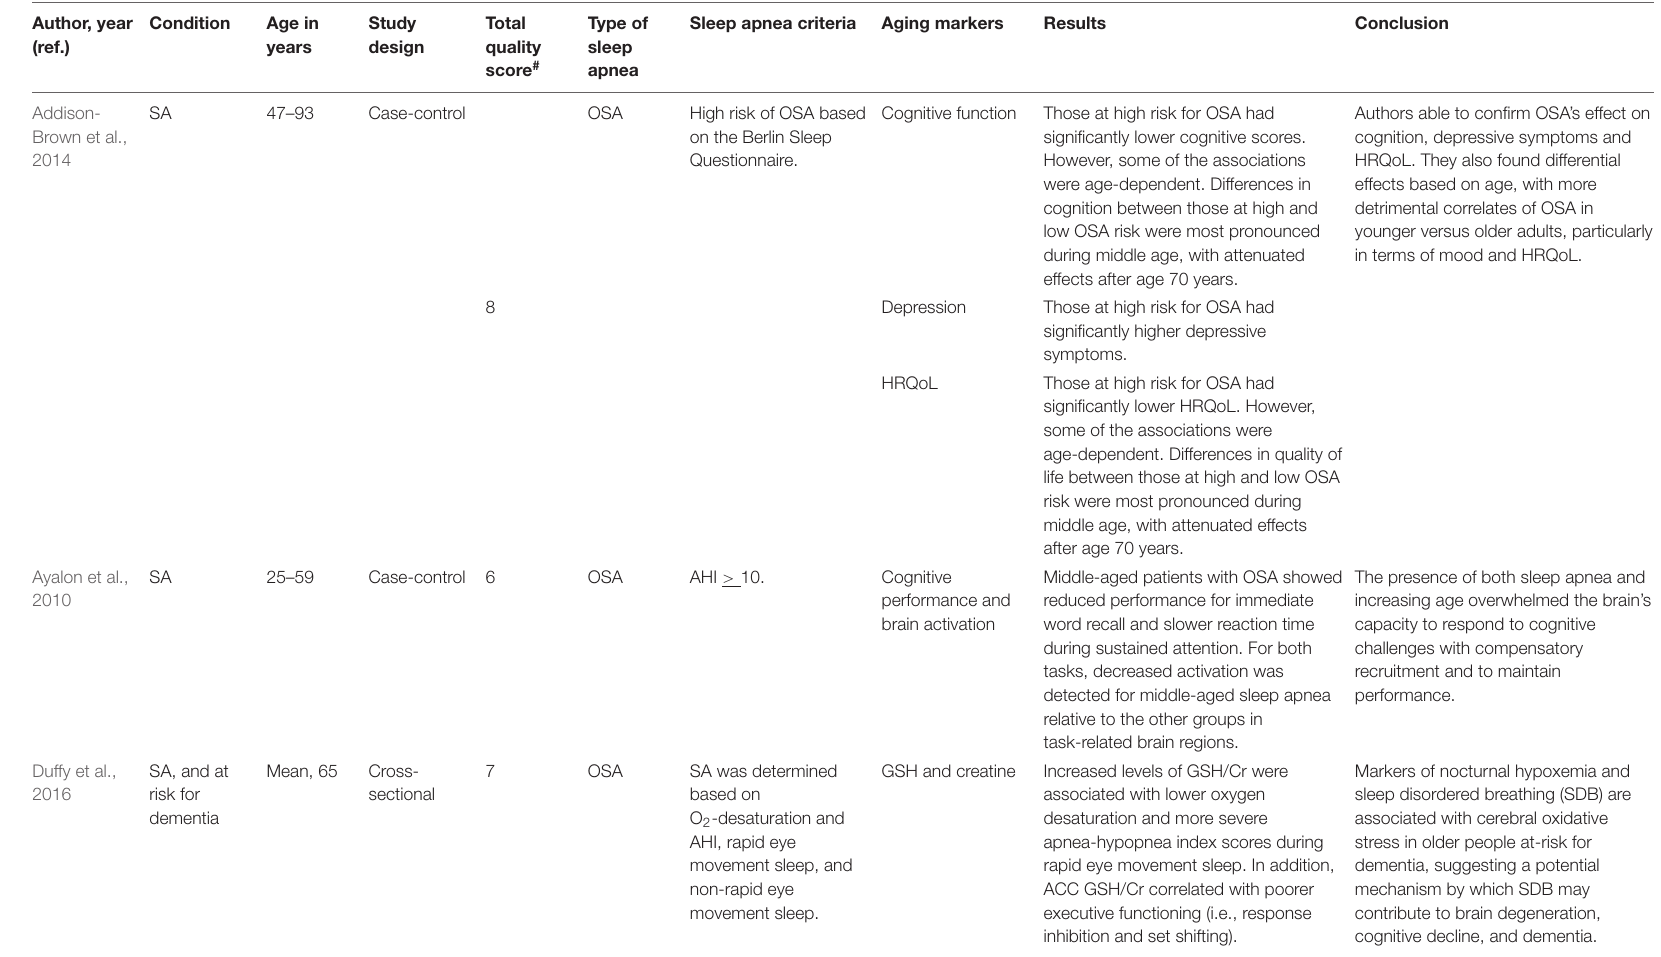
TABLE 4 | The effects of sleep apnea on aging markers and age-related diseases. Author, year